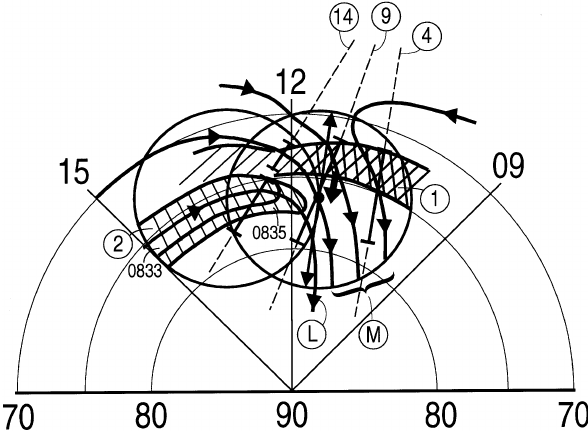
Fig. 2. Schematic overview of the observations of aurora (hatched areas) and convection (with merging (M) and lobe (L) cells), rep- resenting the interval 08:33–08:38UT on 14 January 1999. The coordinate system is magnetic local time (MLT)/ magnetic lati- tude (MLAT). Approximate fields of view of auroral all-sky im- agers at Ny ˚Alesund, Svalbard and Heiss Island, Russia, are marked by circles. Arrowed meridional line indicate the field of view of the meridian scanning photometer (MSP) in Ny ˚Alesund (76.1 ◦ MLAT). Beams 4, 9, and 14 of the CUTLASS Finland radar are indicated, as well as different auroral